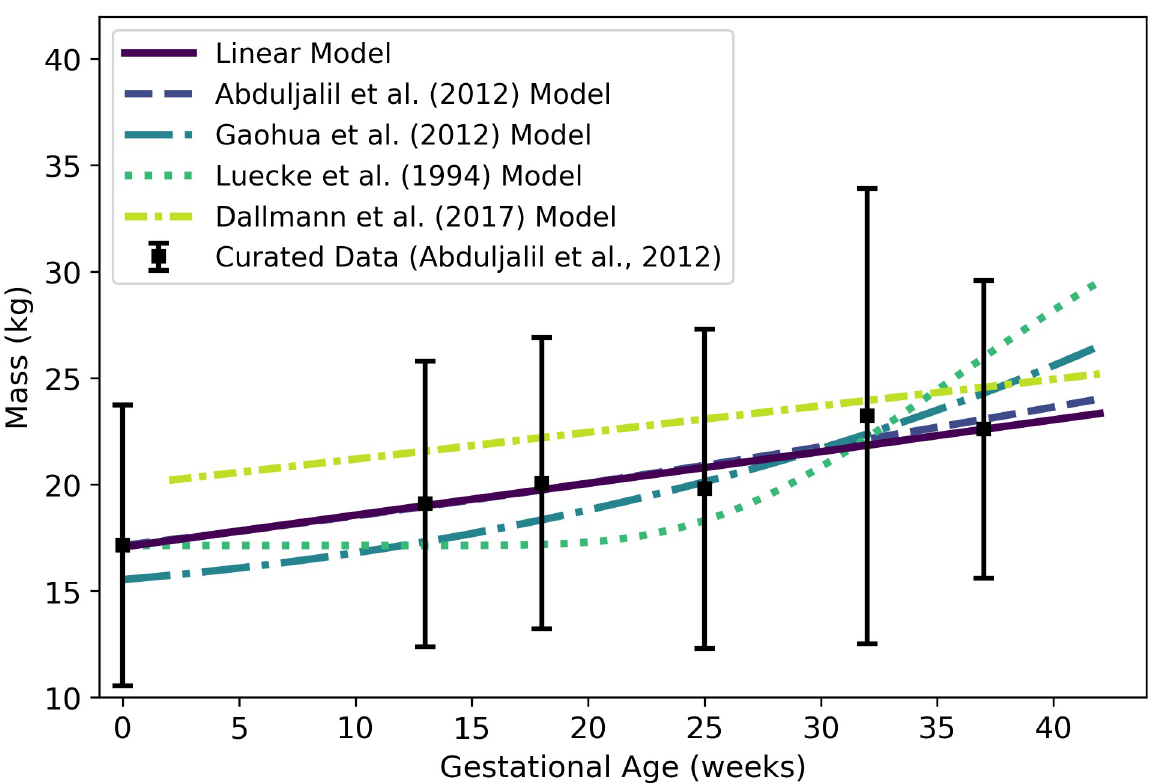
Fig 3. Adipose tissue mass of a human mother of vs. gestational age. The linear model (solid line) given by Eq 3 was selected as the most parsimonious model in our analysis. The models of Abduljalil et al. [28] and Gaohua et al. [29], both quadratic, were calibrated using the same curated data set [28] used by us. The latter of these models was modified as described in the text. The model of Luecke et al. [15] was calibrated using different data. It predicts maternal fat mass as a function of total fetal mass, and was interpreted as described in the text. Dallmann et al. [3] also selected a linear model, but they calibrated their model with different data.